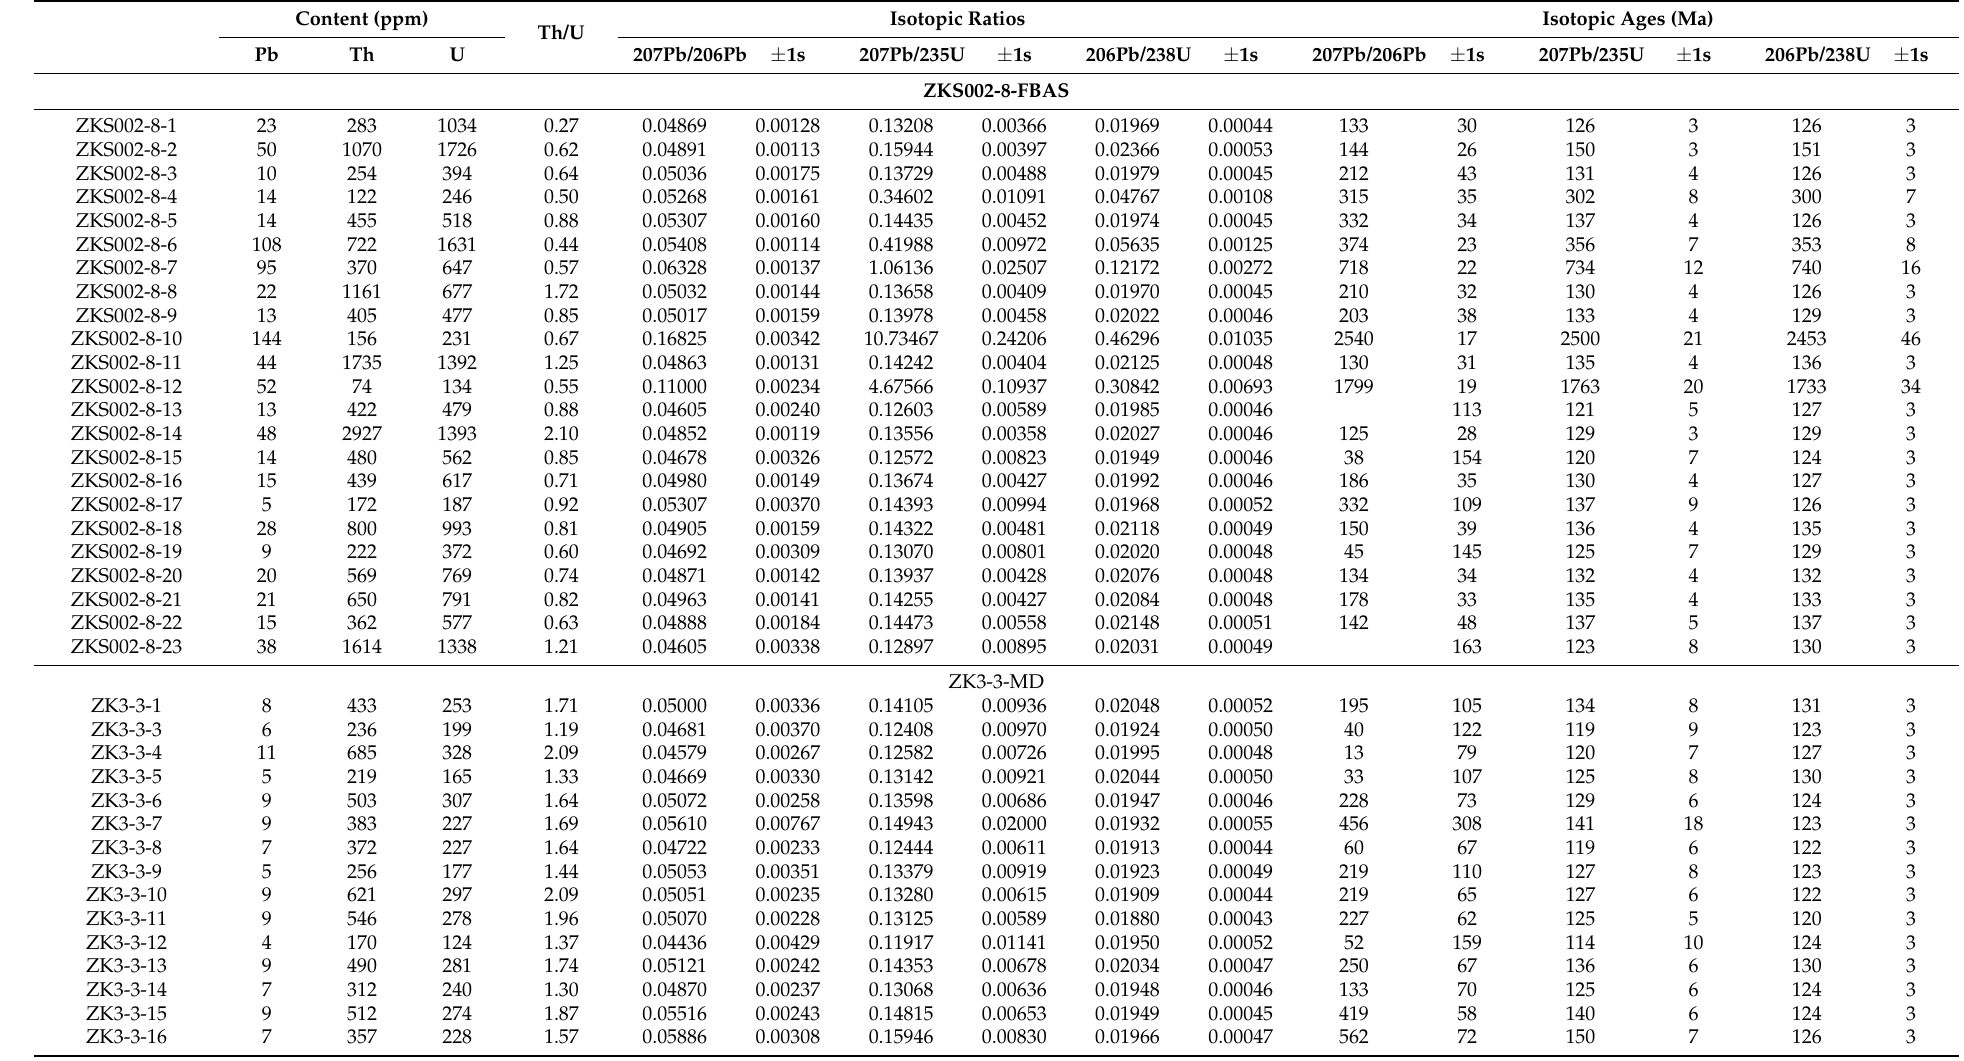
Table 1. LA-ICP-MS U-Pb zircon data for the Hongshan